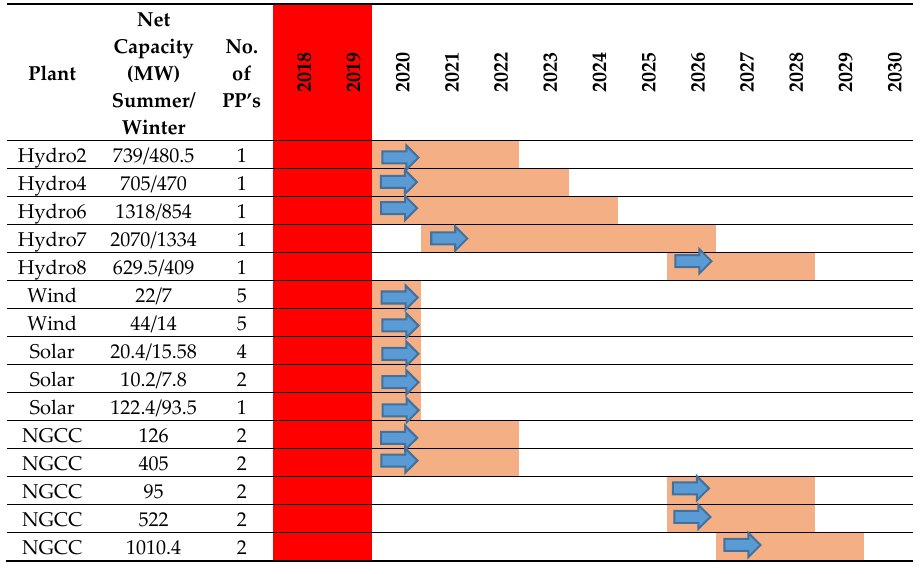
Table A12. Details of the Plants Installation under Capacity Expansion: Normal GDP CCS on New PP’s (with 30% Operation Constraint on FF).